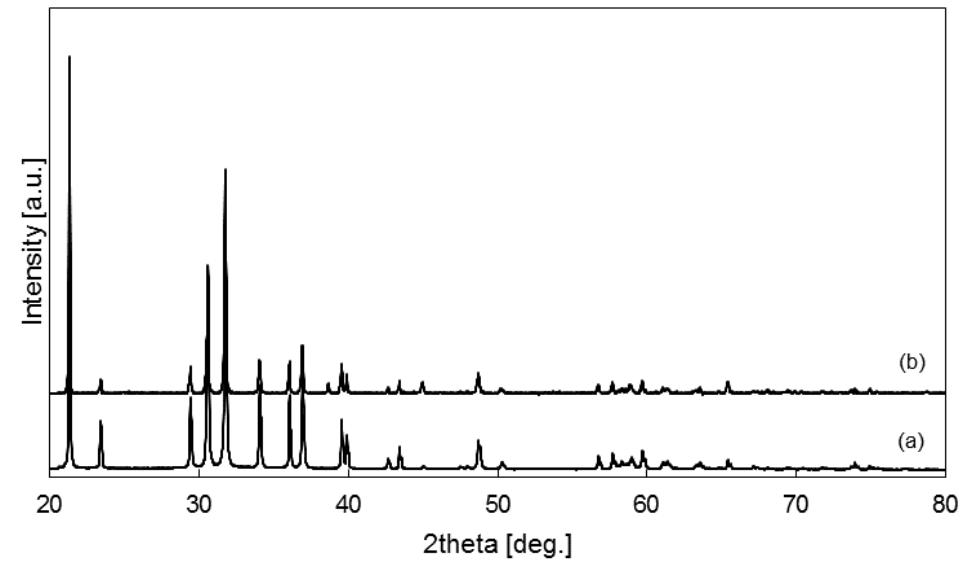
Figure 8. XRD profiles of ( a ) the Li 2 CO 3 reagent and ( b ) the precipitate.